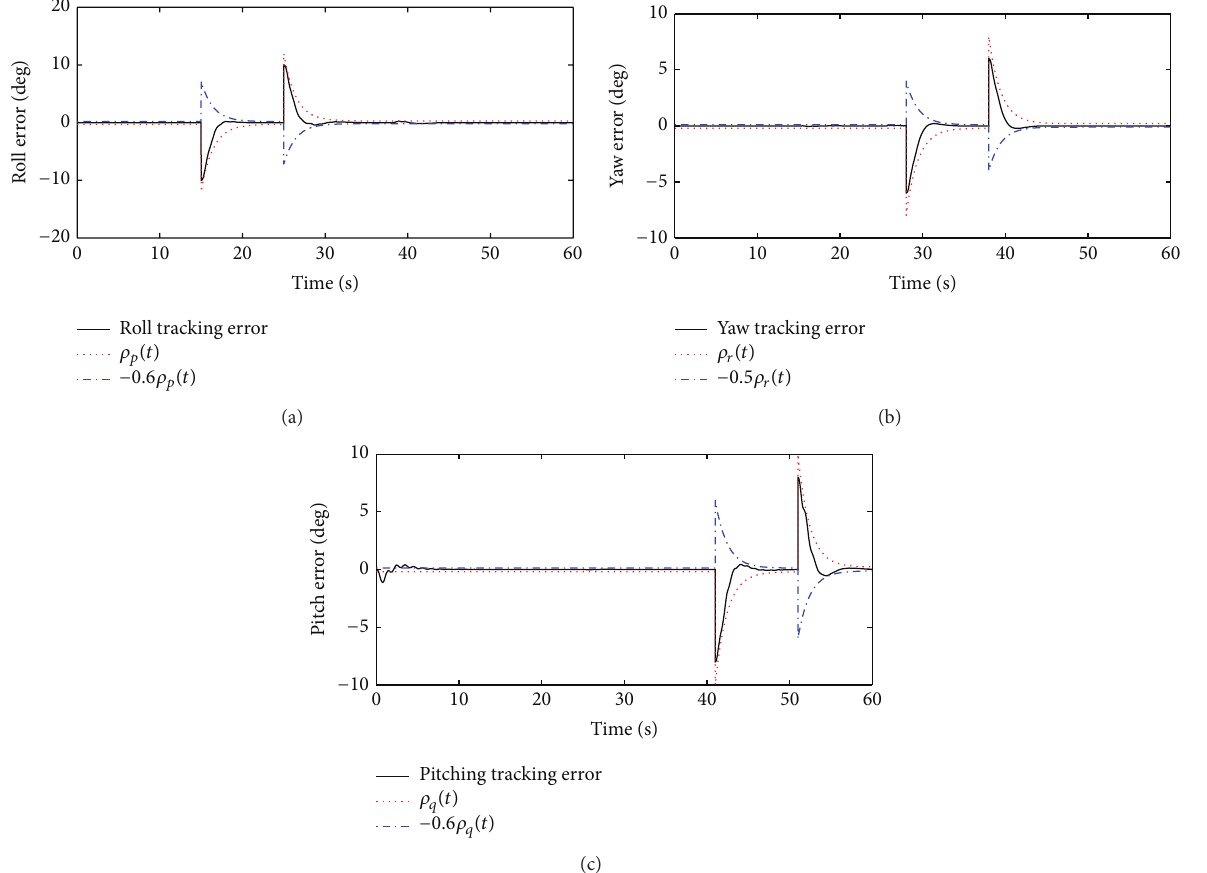
Figure 7: Tracking errors of the attitude angles with model